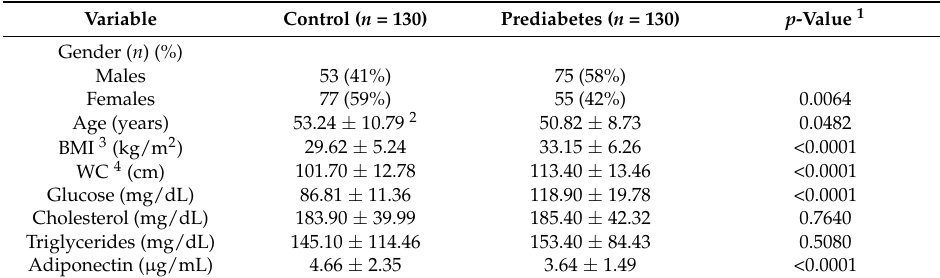
Table 2. Baseline variables of study